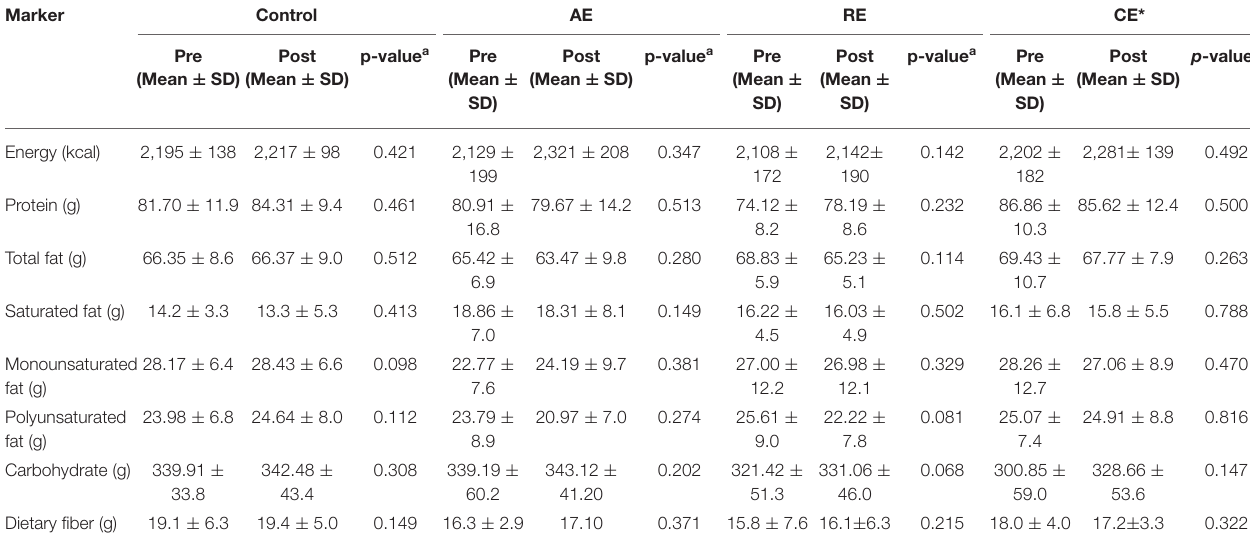
TABLE 1 | Dietary intake at baseline and end of the interventions in the study groups. Marker